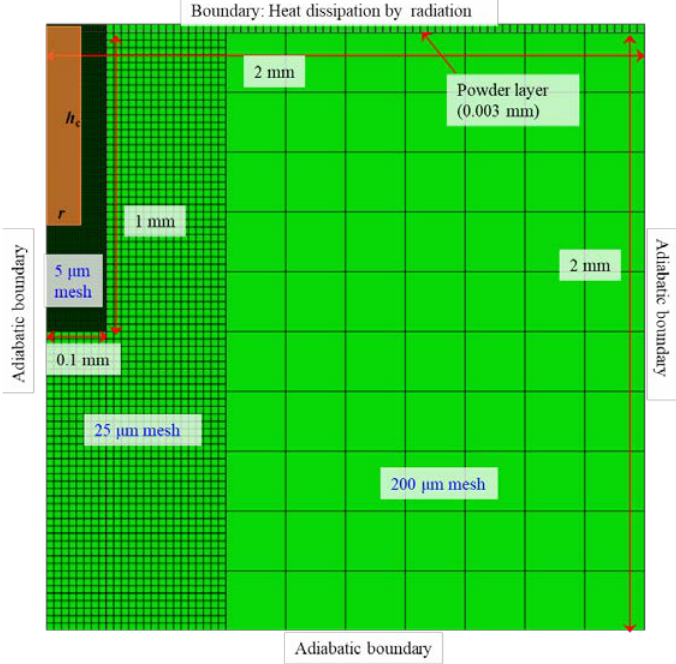
Figure 4. The simulation settings in the two-dimensional thermal conduction FEM analysis.